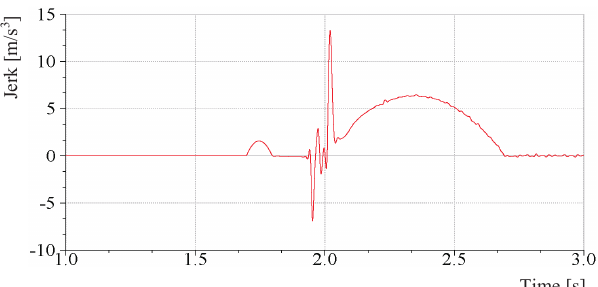
Figure 15. Jerk change during the downshifting process after the improvement of the SOWC